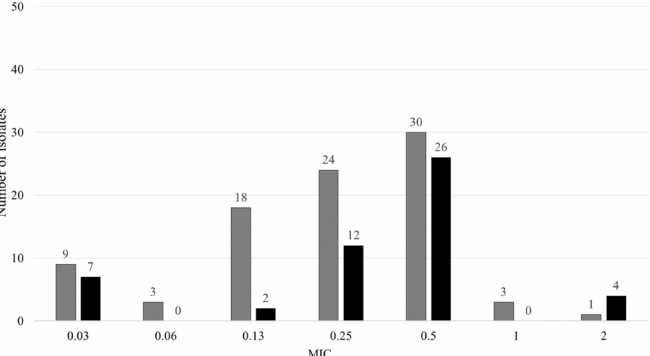
Figure 1. Distribution of minimum inhibitory concentration (MIC, mg/L) of CFZ for MDR ( n = 82, gray bar) and XDR ( n = 40, black bar). The resistance criterion for CFZ was read as >1 mg/L. The CFZ resistance rate was higher in XDR than in MDR isolates ( p = 0.001).